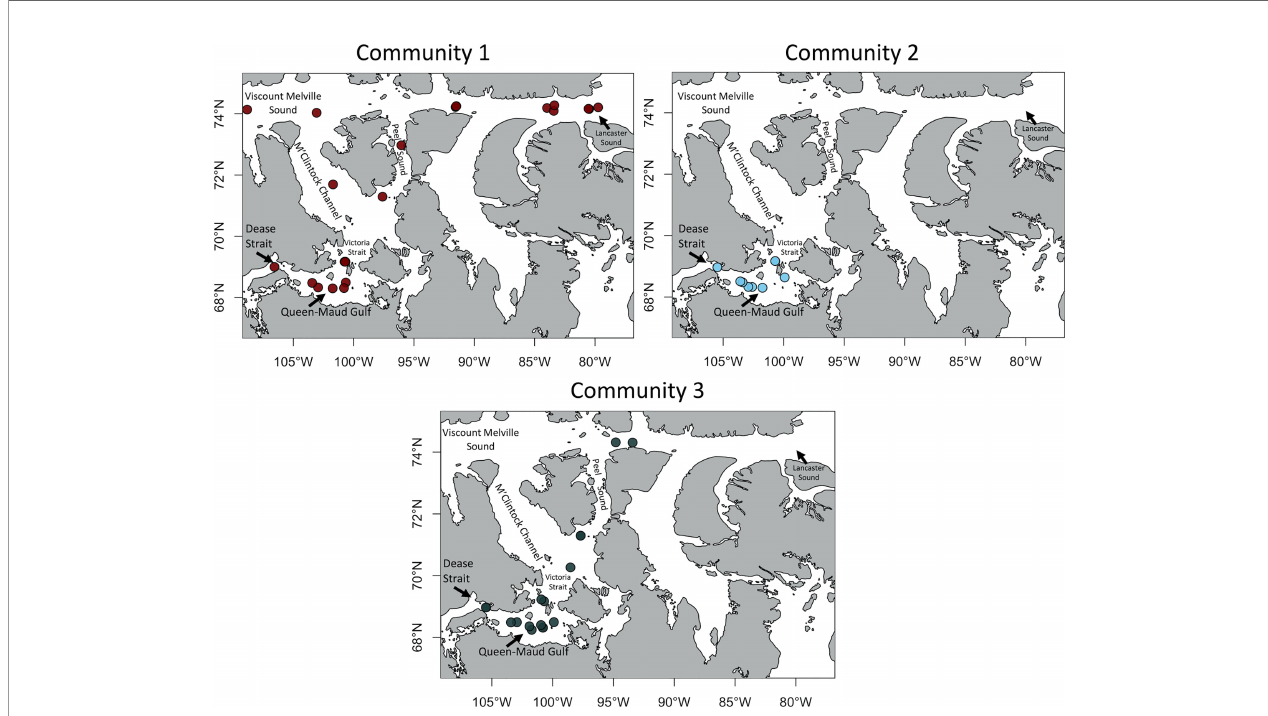
FIGURE 7 | Location of the 3 epifaunal communities across the Kitikmeot sea region and Parry Channel. Colors represent the communities determined at Figure 6